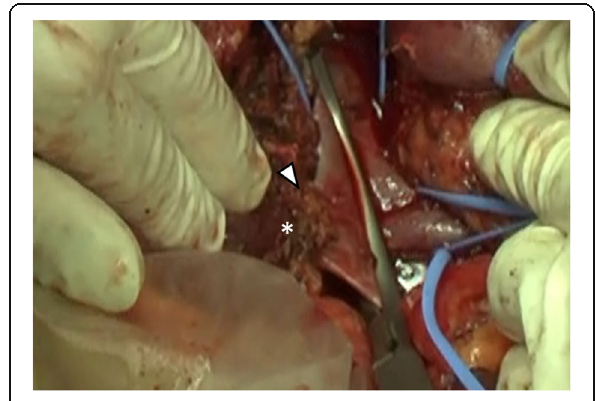
Fig. 2 Intraoperative findings of case 1. Stiff attachment between the tumor ( asterisk ) and the inferior vena cava (IVC) was identified ( arrowhead )